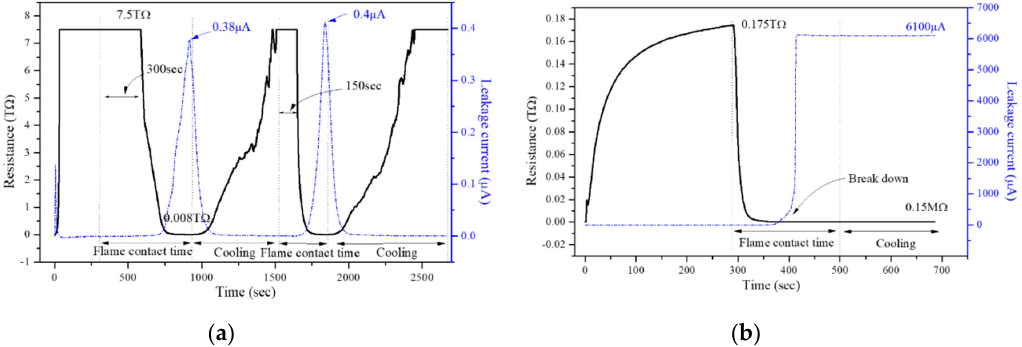
Figure 4. Insulation resistance of cables with flame contact. ( a ) TFR-8 cable ( b ) VCTF cable.